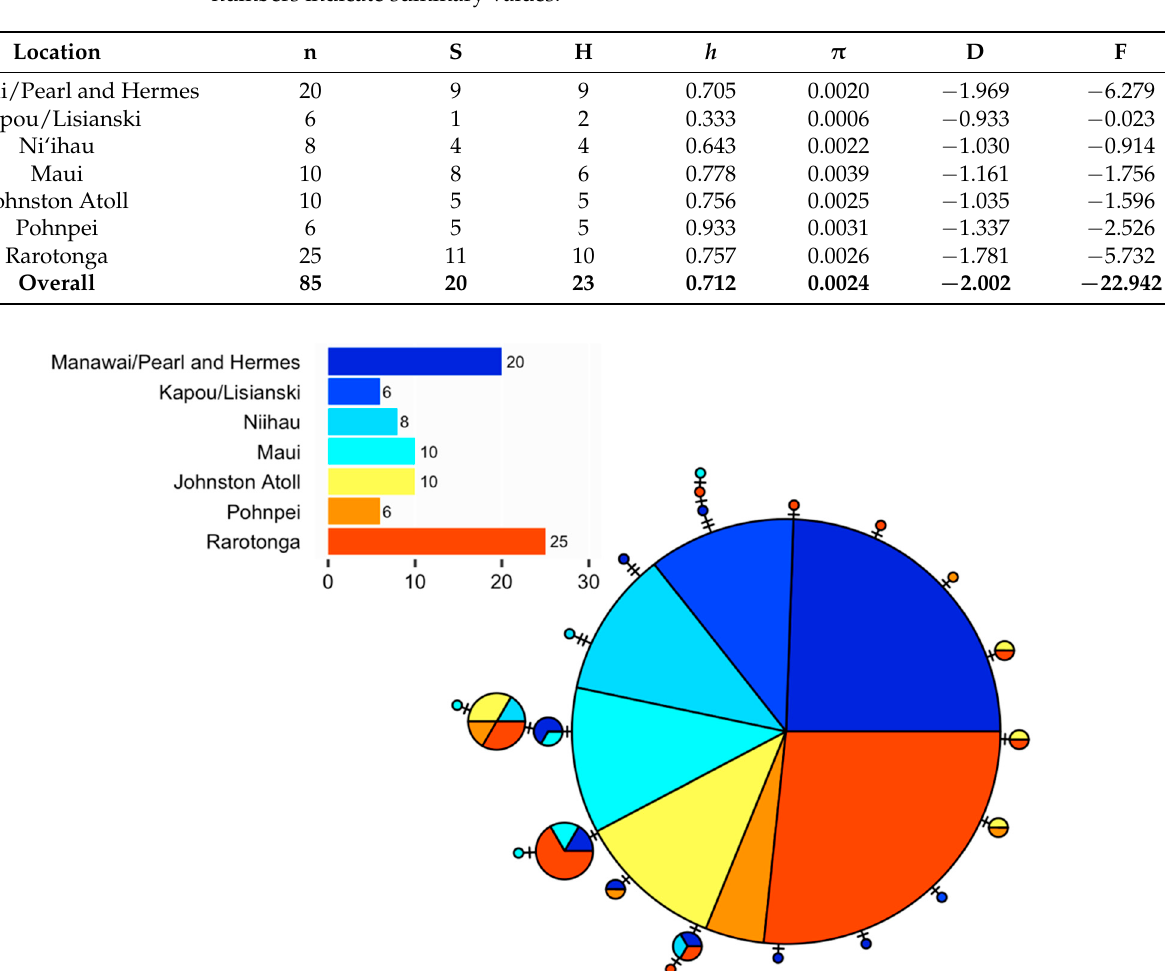
Table 1. Population genetic diversity summary statistics for Myripristis chryseres across all sampling locations (n = number of samples sequenced, S = number of segregating sites, H = number of unique haplotypes, h = haplotype diversity, π = nucleotide diversity, D = Tajima’s D, F = Fu’s F). Bold numbers indicate summary values.